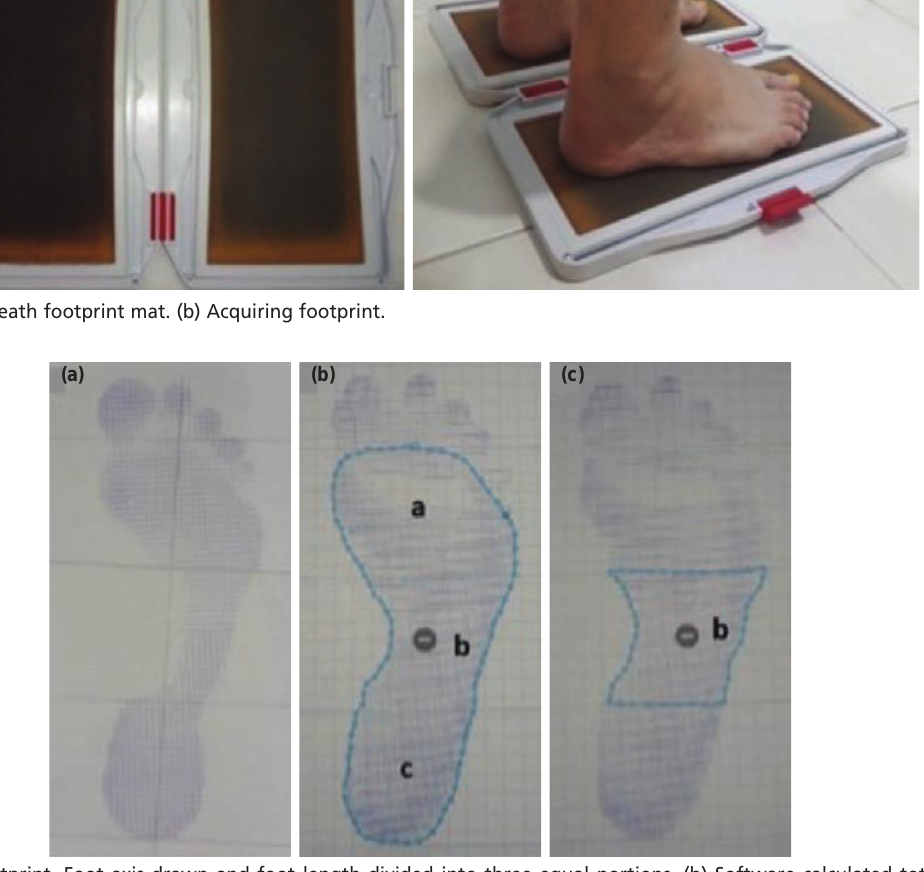
(a) Raw footprint. Foot axis drawn and foot length divided into three equal portions. (b) Software calculated total area. (c) Fig. 2: Software calculated midfoot area. Arch Index is taken as b/ (a+b+c).